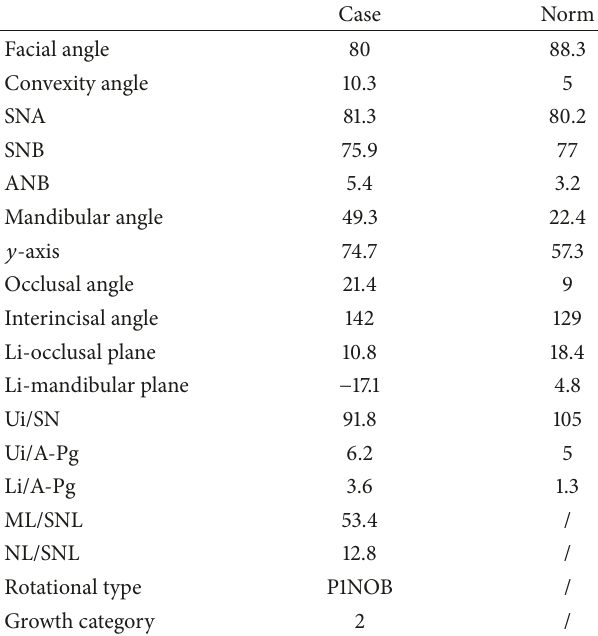
Table 4: Postsurgery cephalometric